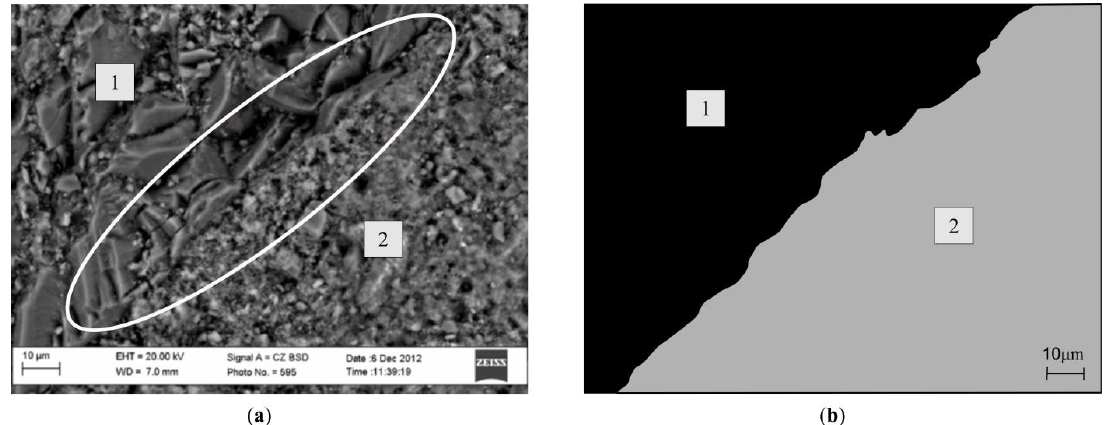
Figure 9. Contact area of the hardened cement stone and natural aggregate, ( a ) microscopic view; ( b ) view analyzed with computer graphic software; 1 — natural aggregate; 2 — cement stone.